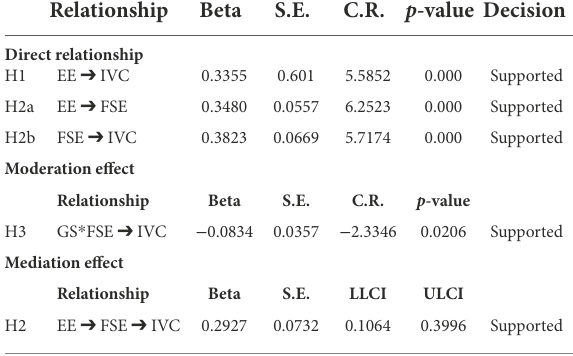
TABLE 7 Moderated and mediation